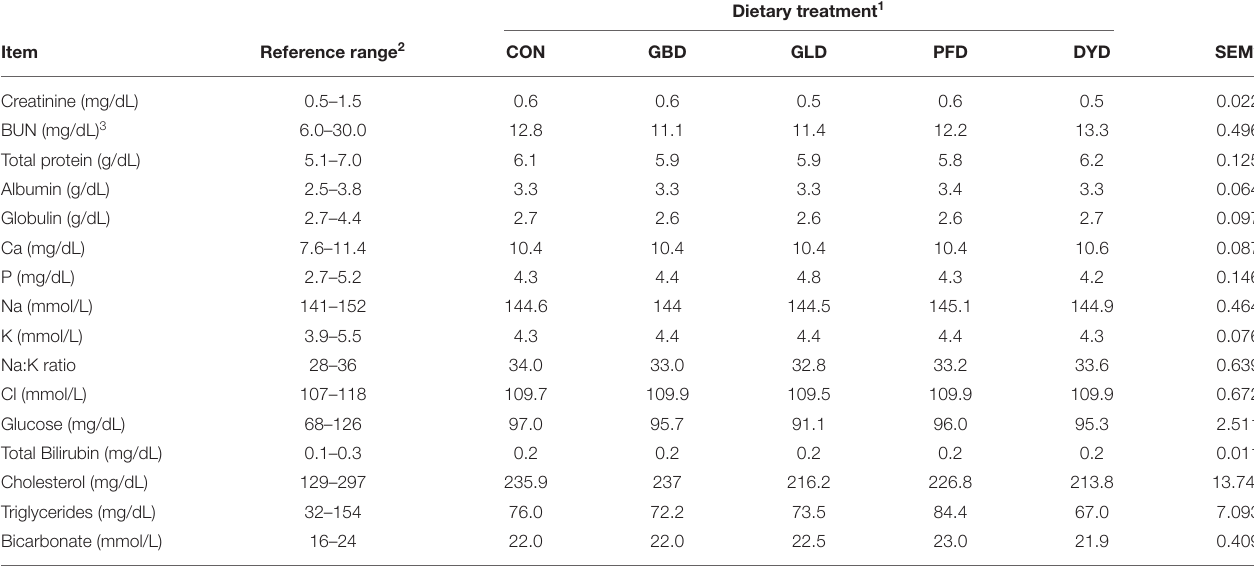
Dietary treatment